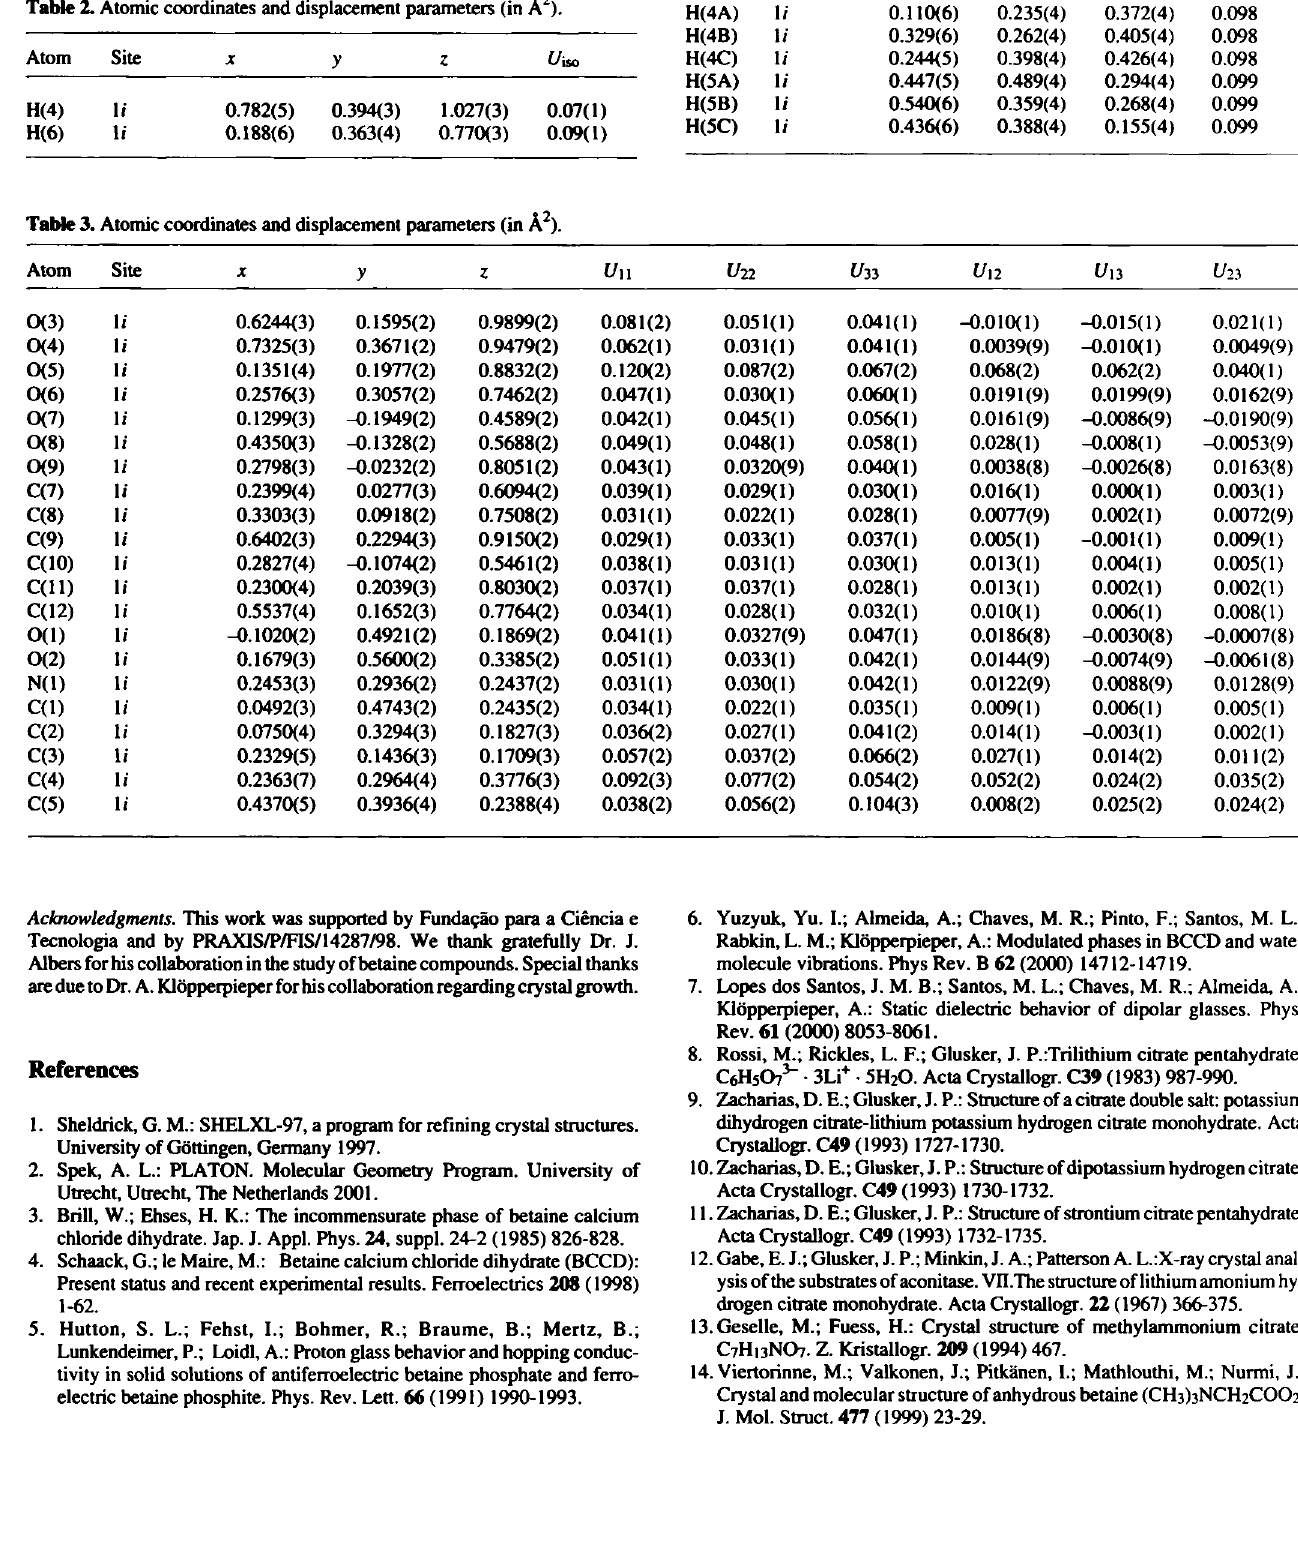
Table 2. Atomic coordinates and displacement parameters (in Â 2 ).